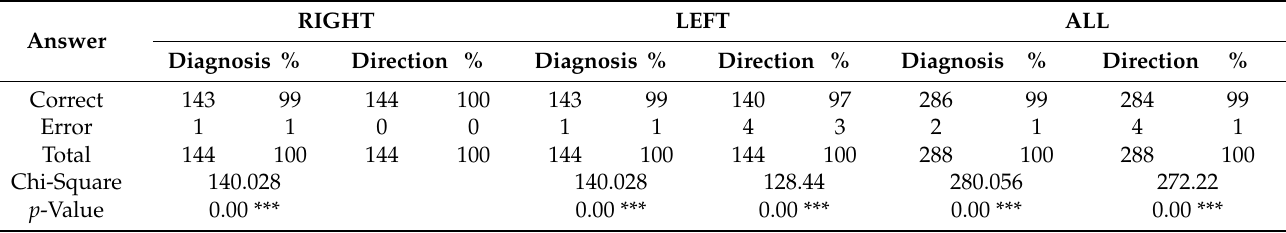
Table 3. Validity of OCI at Grade I (1 ◦